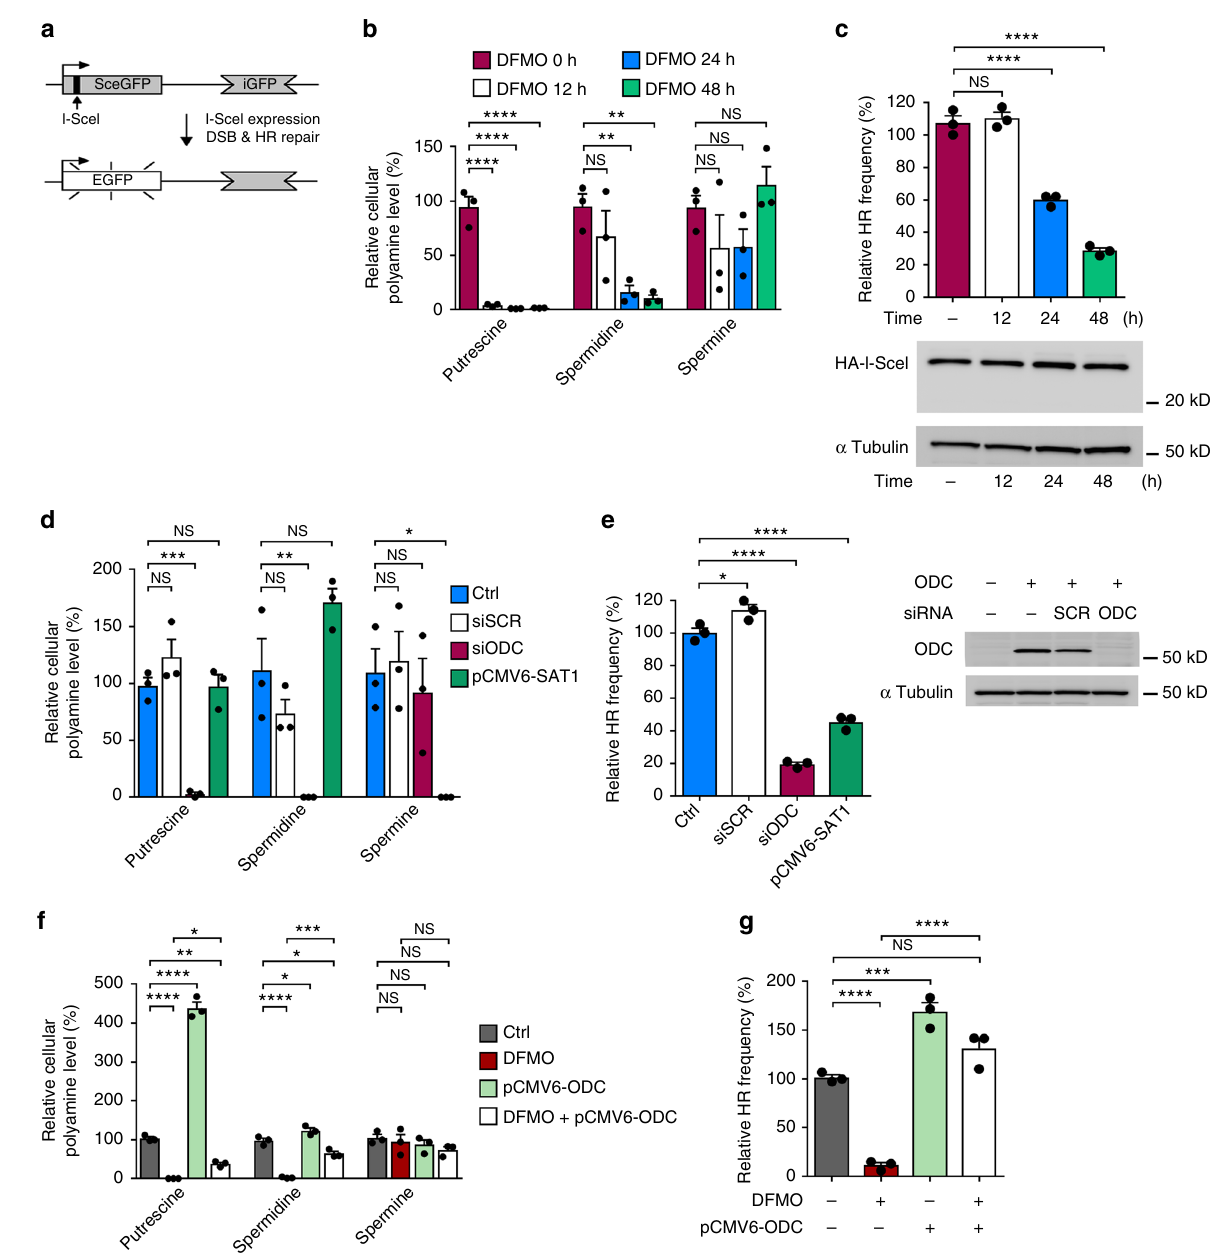
Fig. 2 Polyamines affect DSB repair by homologous recombination. a Schematic of the DR-GFP reporter assay to assess HR activity. b , c U2OS cells were treated with 500 μ M DFMO for the indicated times. b Levels of three polyamines were quanti fi ed and normalized to that in untreated cells. Note that,